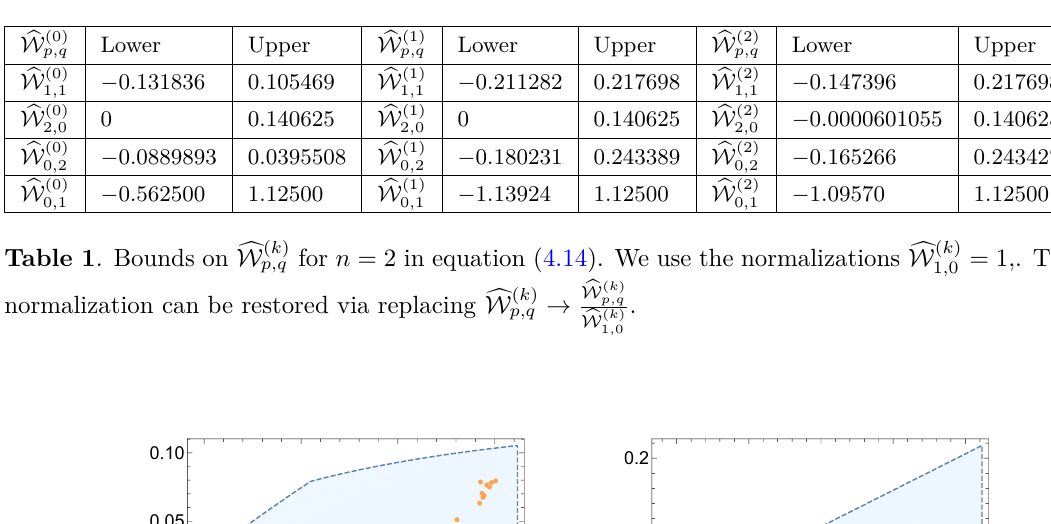
b W ( k ) p,q . p,q → b W ( k ) 1 , 0